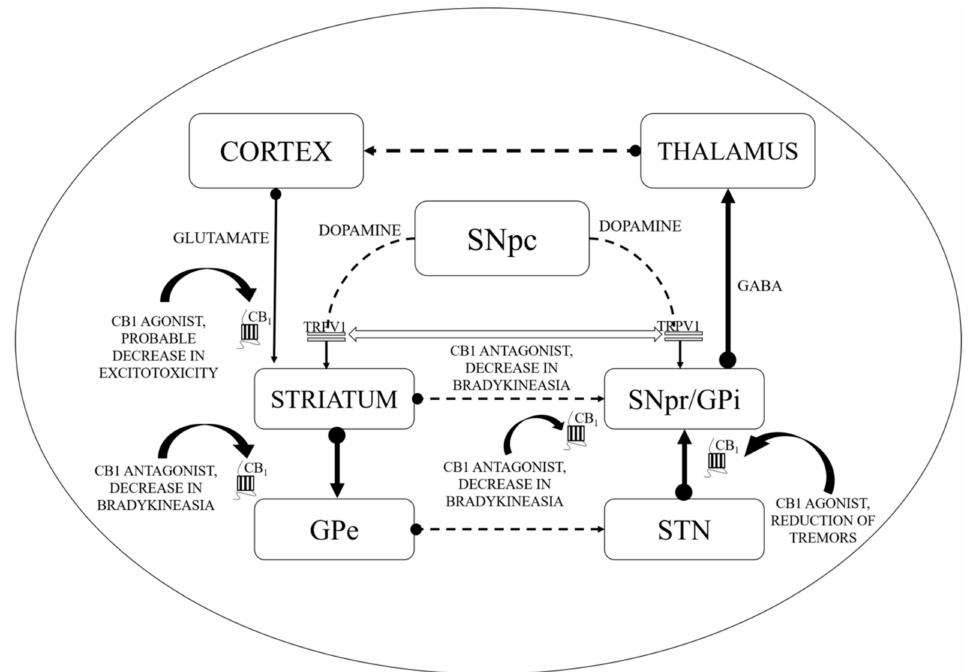
Figure 1. Basal ganglia circuitry and mechanisms depicting the cannabinoid (CB) targets in motor disability improvement in Parkinson’s disease (PD). CB1—Cannabinoid 1 receptor; GABA— γ -aminobutyric acid; GPe—Globus pallidus (external); GPi—Globus pallidus (internal); SNpc—Substantia nigra pars compacta; SNpr—Substantia nigra pars reticulata; STN—subthalamic nucleus; TRPV1—Transient receptor potential type-1 vanniloid; dotted line arrows—underactive; full line